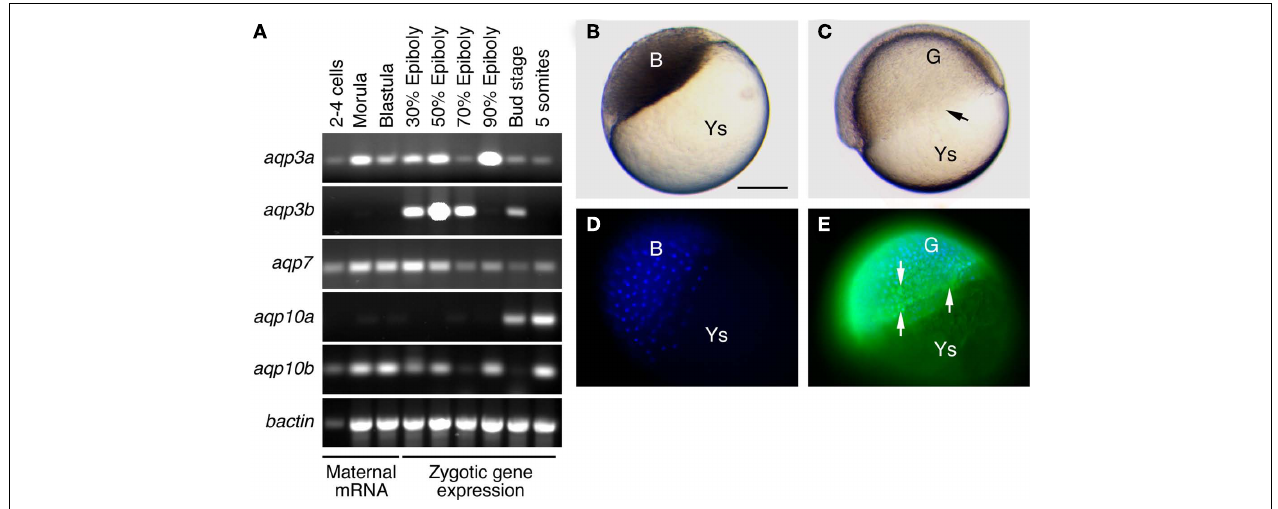
Aqp3b in zebrafish blastula embryos (left) and 50% epiboly embryos (right) using specific antibodies (Chauvigné et al., 2011). (C) The involuting edge of the gastrula is indicated with an arrow. (D–E) Aqp3b is not detected in the blastula (D) , whereas it appears in migrating blastomeres [ (E) arrows] during gastrulation. Nuclei of blastomeres are counterstained with DAPI. Bar, 500 μ m.Ys, yolk sac; B, blastomeres; G, gastrula. Bar, 500 μ